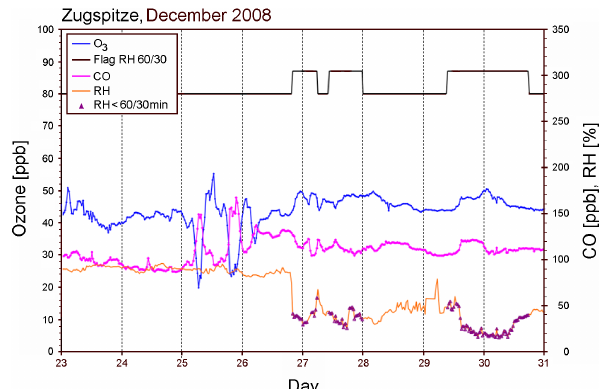
Figure 9. Zugspitze data around 26 December 2008; during the Fig. 9. Zugspitze data around December 26, 2008; during the intrusion period on late December 26 intrusion period on late 26 December and on 27 December only and on December 27 just a slight anti-correlation of ozone and carbon monoxide is seen. a slight anti-correlation of ozone and carbon monoxide is